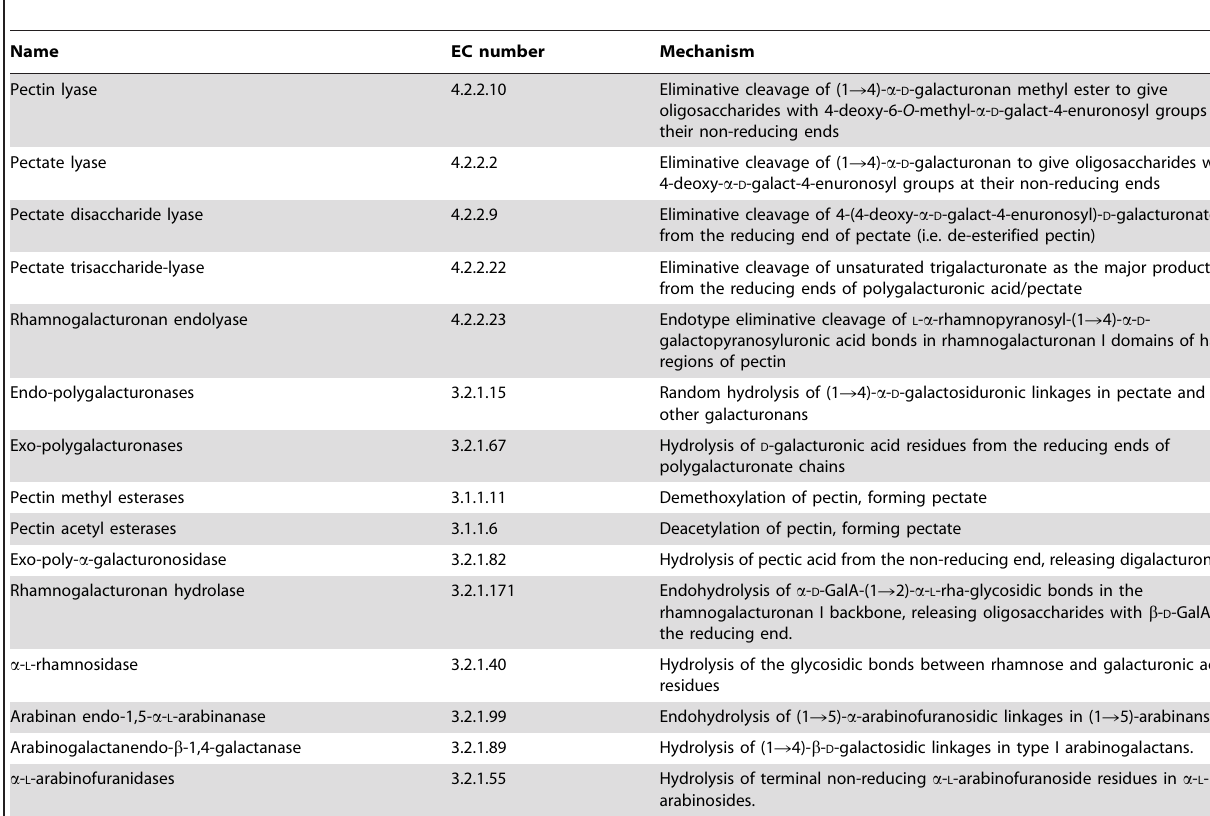
Table 1. Enzymes that contribute to the degradation of